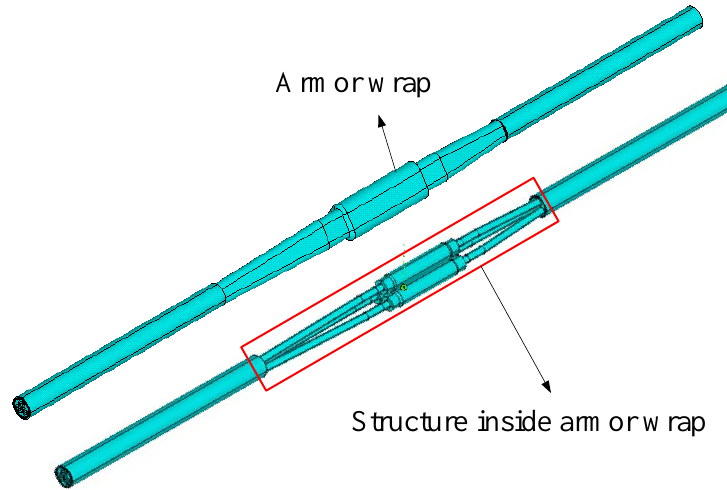
Figure 2. The calculation model of three-core cable